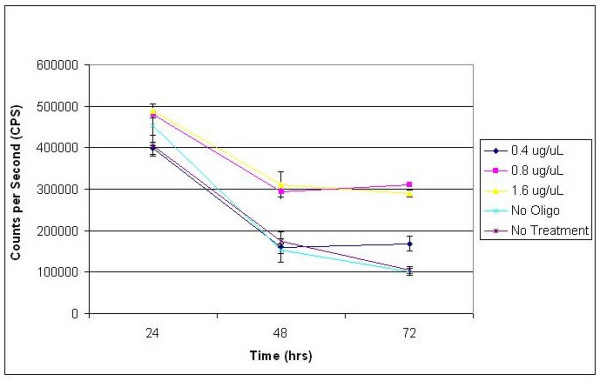
Viability assay of PC12 cells transfected with various HDG concentrations. The PC12 cell line, Htt14A2.6, was transfected with varying amounts of HDG in Lipofectamine 2000. The Promega CellTiter-Glo Luminescent cell viability assay was used to analyze the viability of each treatment as a function of time. One control is a mock-transfected cell culture containing lipofectamine 2000 but no oligonucleotide; whereas the no treatment control presented here indicates cells that have received neitheroligonucleotide nor lipofectamine. Statistics were performed by using the standard deviation on 27 luminescent readings for every sample at each time point.